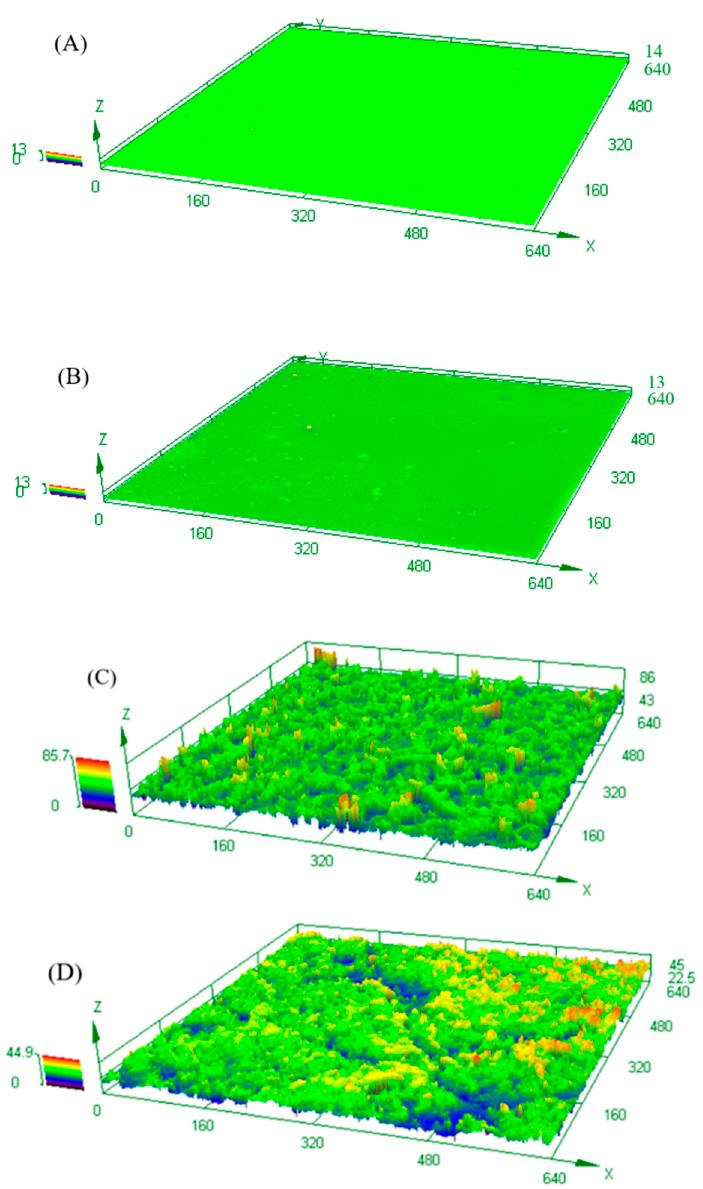
Figure 3. Micromorphologies of different WPU composites of ( A ) #0; ( B )#3 LSWPUC; ( C )#3 SHWPUC; and ( D ) #4 SHWPUC, (µm).